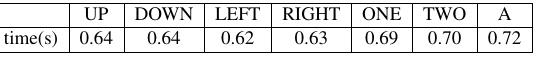
Table 4. each processing time of input command on the shell